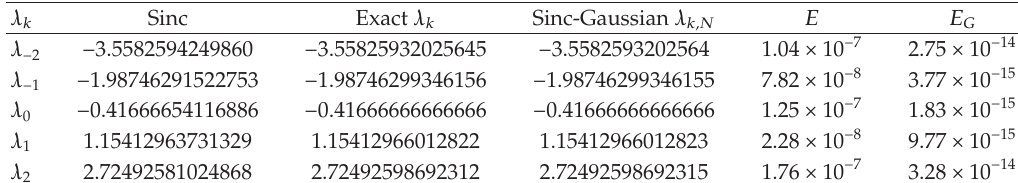
Table 1: The absolute errors of sinc-Gaussian and the classical sinc-method with N (cid:7) 20, h (cid:7) 0 . 2, ω (cid:7) 1 .